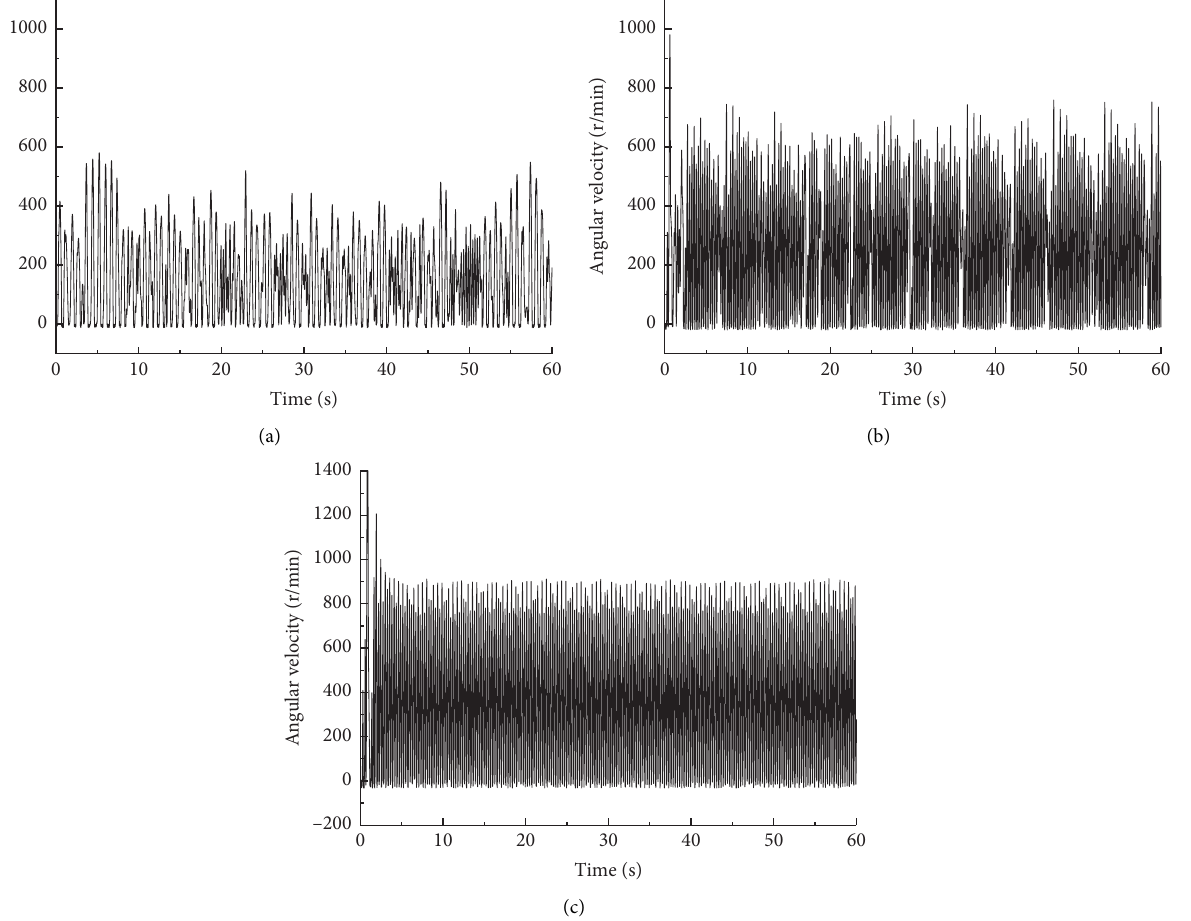
Figure 12: Angular velocity for various driving velocities: (a) 100r/min. (b) 200r/min. (c)